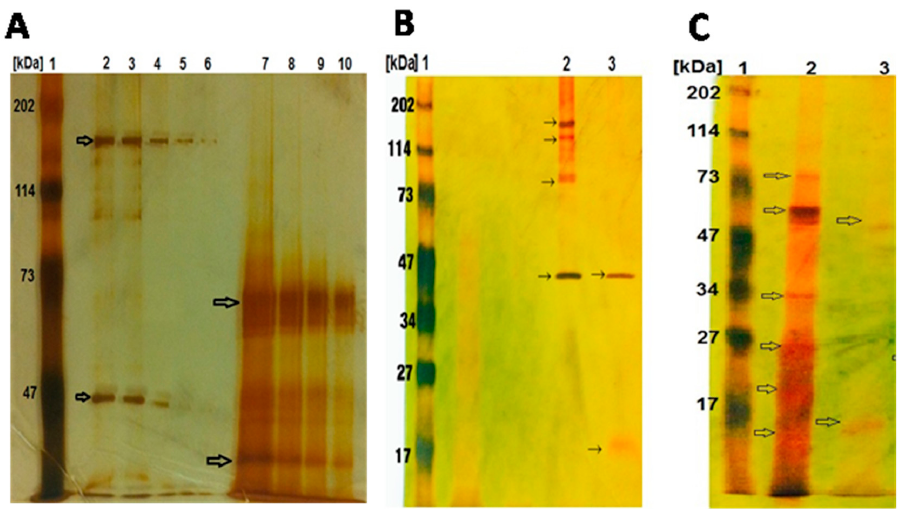
Figure 4. SDS-PAGE analysis of solubilized native and activated Bt parasporal crystal inclusions. PS proteins was resolved onto 12% SDS-PAGE gel and the bands were detected by silver staining, which was performed as detailed in the methods section. ( A ) Protein profiles of nascent PS proteins from Bt5 and Bt7. Lanes 2–6 were loaded with PS proteins from Bt5 at 10 µ g (2&3), 3.6 µ g (4), 1.6 µ g (5)